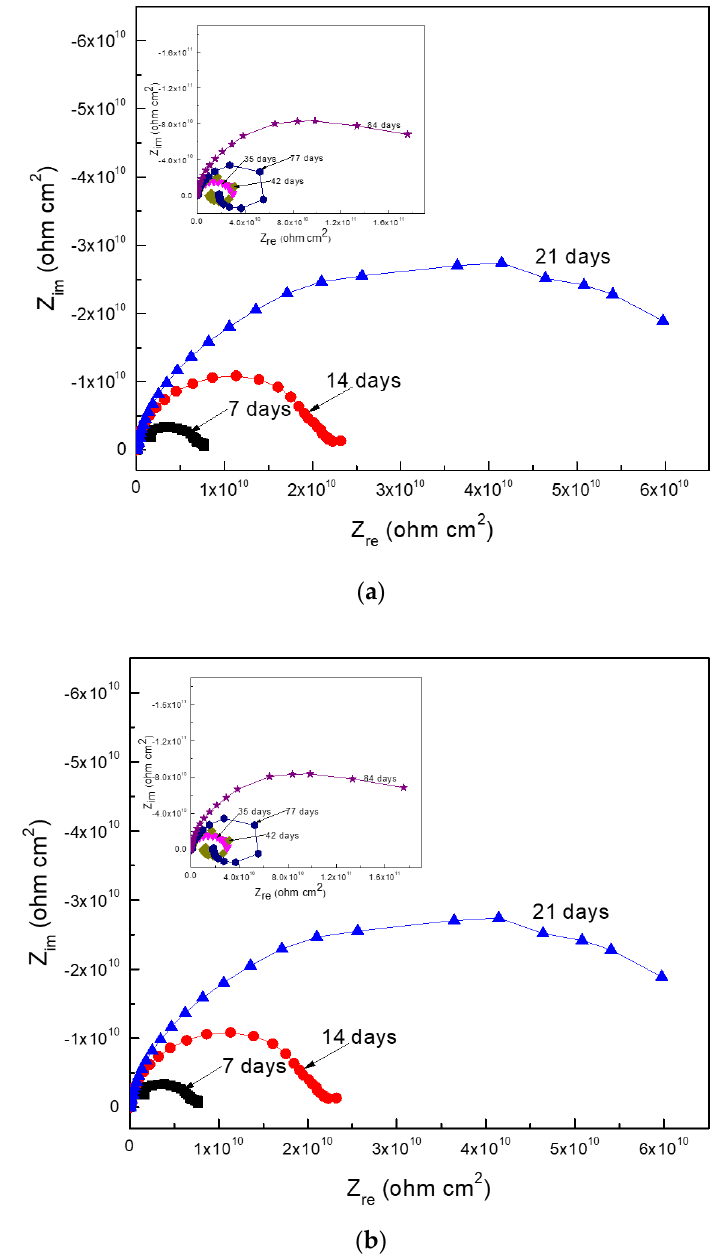
Figure 10. EIS data in the ( a ) Nyquist and ( b ) Bode formats for Al in the blend containing ethanol obtained from oranges.